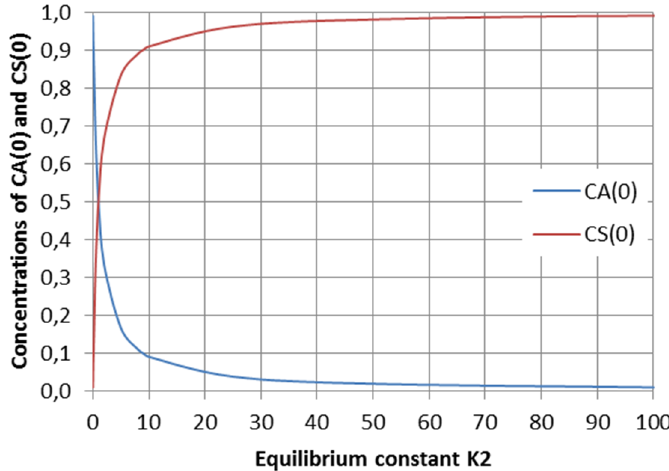
Figure 6. Initial values C A (0) and C S (0), C R (0) = 0 as a function of equilibrium constant K 2 in the special case of a parallel reaction system, where step 1 is slow and step 2 is rapid.